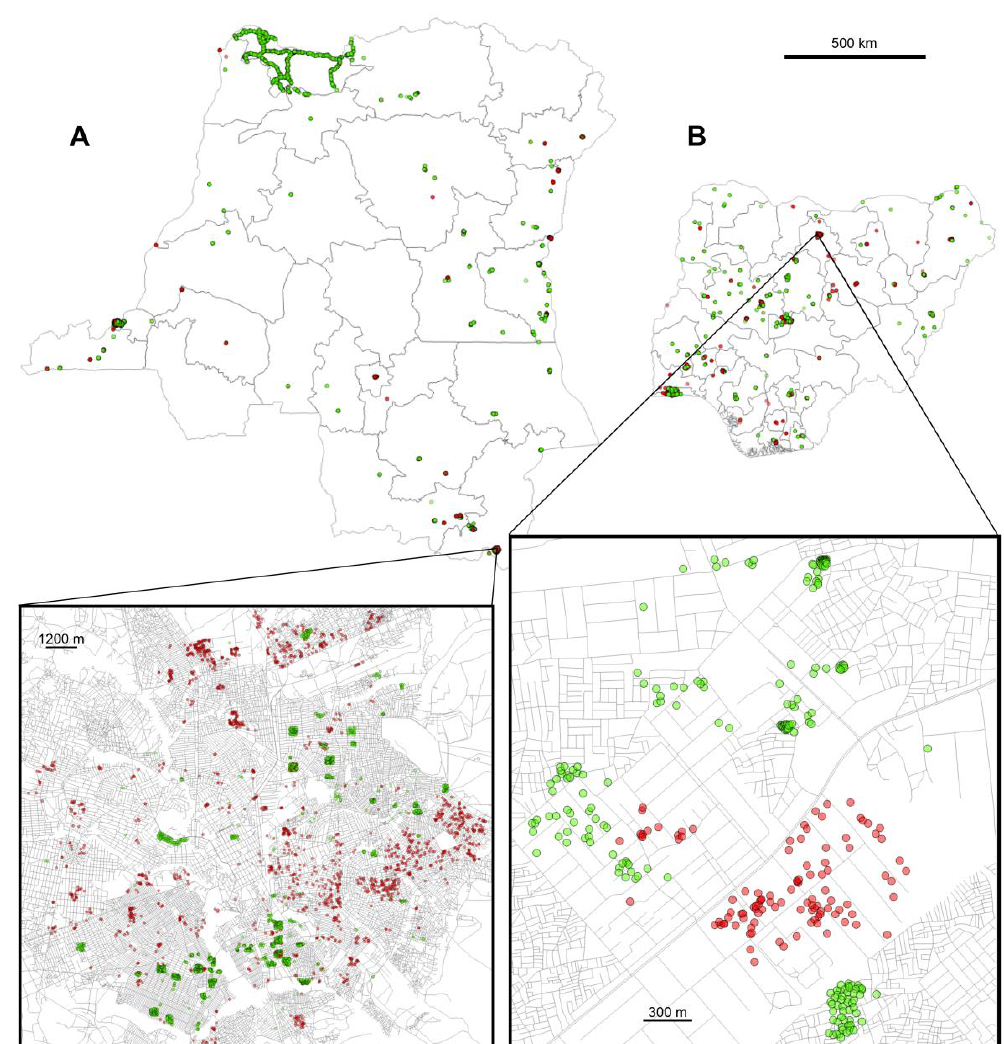
Figure 1. Distribution of OpenStreetMap (OSM) and other building label data, in ( A ) the Democratic Republic of the Congo (break-out box shows city of Lubumbashi in greater detail, including road network) and ( B ) Nigeria (break-out box shows city of Kano). Green and red points represent residential and nonresidential structures respectively. Data are plotted with opaque colours, and thus darker colours indicate more buildings of the same type (UCLA and KSPH [26]; eHealth Africa and WorldPop (University of Southampton) [25]; ORNL [24]; World Bank Group [23]; © 2020 OpenStreetMap contributors).